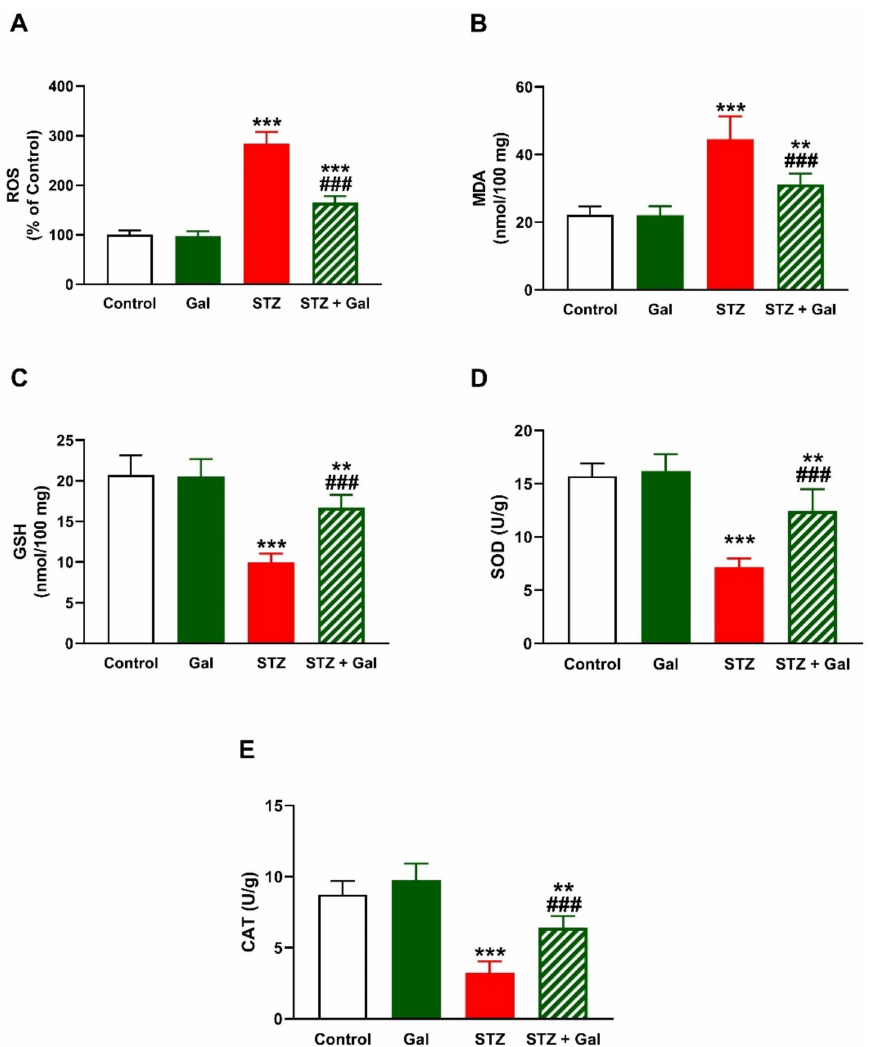
Figure 6. Galangin attenuates hepatic oxidative stress in diabetic rats. Galangin decreased hepatic ROS ( A ) and MDA ( B ), and increased GSH ( C ), SOD ( D ), and CAT ( E ) in diabetic rats. Data are mean ± SEM, n = 6. ** p < 0.01 and *** p < 0.001 versus control. ### p < 0.001 versus